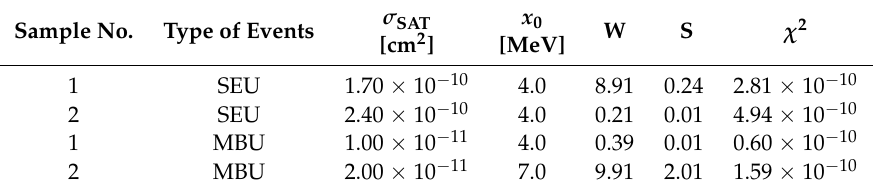
Table 7. Weibull function parameters for SEU and MBU event types based on the χ 2 method. Sample